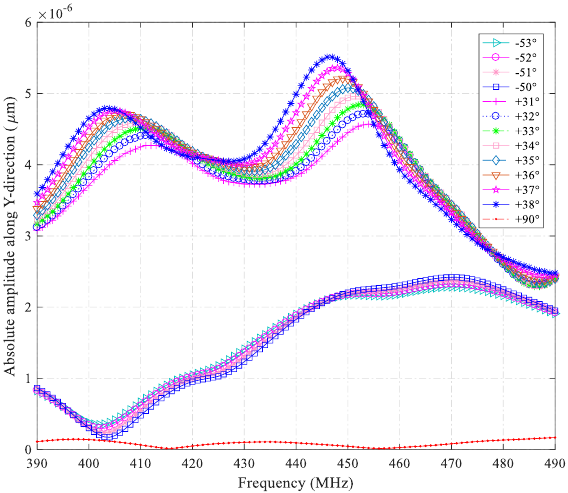
Figure 4. Absolute amplitudes of SH-SAWs along Y-direction regarding different cut angles (rotations from −53° to −50° are with five-fold offset).